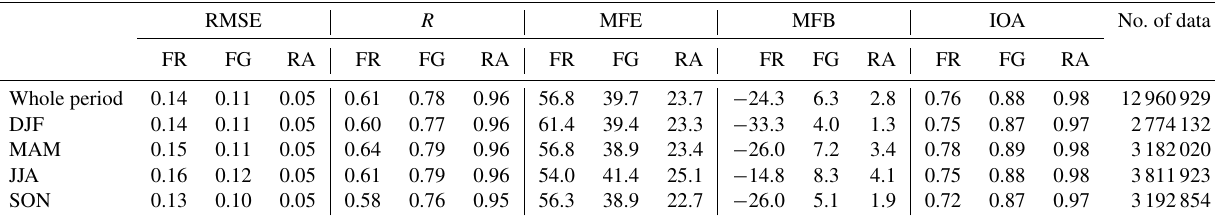
Table 2. Statistical measures of the NRL-UND MODIS AODs versus FR, FG, and RA AODs. RMSE R MFE MFB IOA No. of data